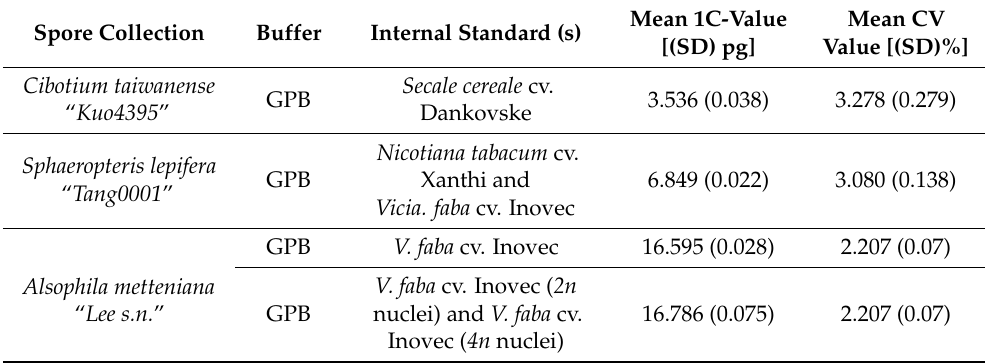
Table 4. C-value estimation of the three spore collections using different buffers and internal standards by interpolation.